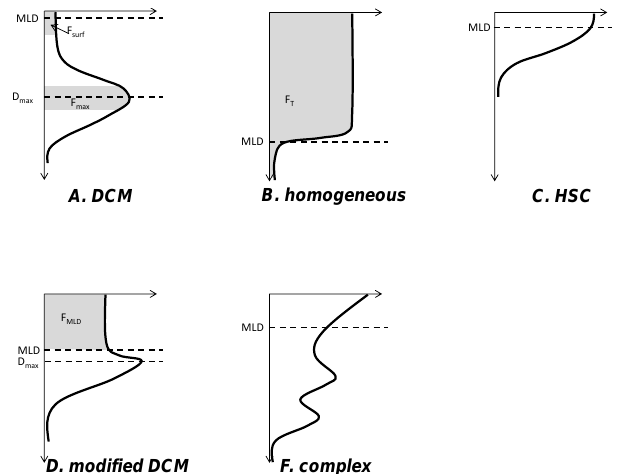
Figure 2. The five standard shapes for [Chl a ] vertical profiles iden- tified in our data set. See Sect. 2.3 of the text for more details about these shapes and for a description of the algorithm used to iden- tify them. Black solid lines represent the normalized [Chl a ] verti- cal profile. Metrics used for the determination of the profile stan- dard shape (i.e., MLD, D max , F surf , F max , F T ; see Sect. 2.3 for definitions) are represented on standard profiles. Although all of these metrics have been computed on each fluorescence profile, they could not be represented on the same profile for practical